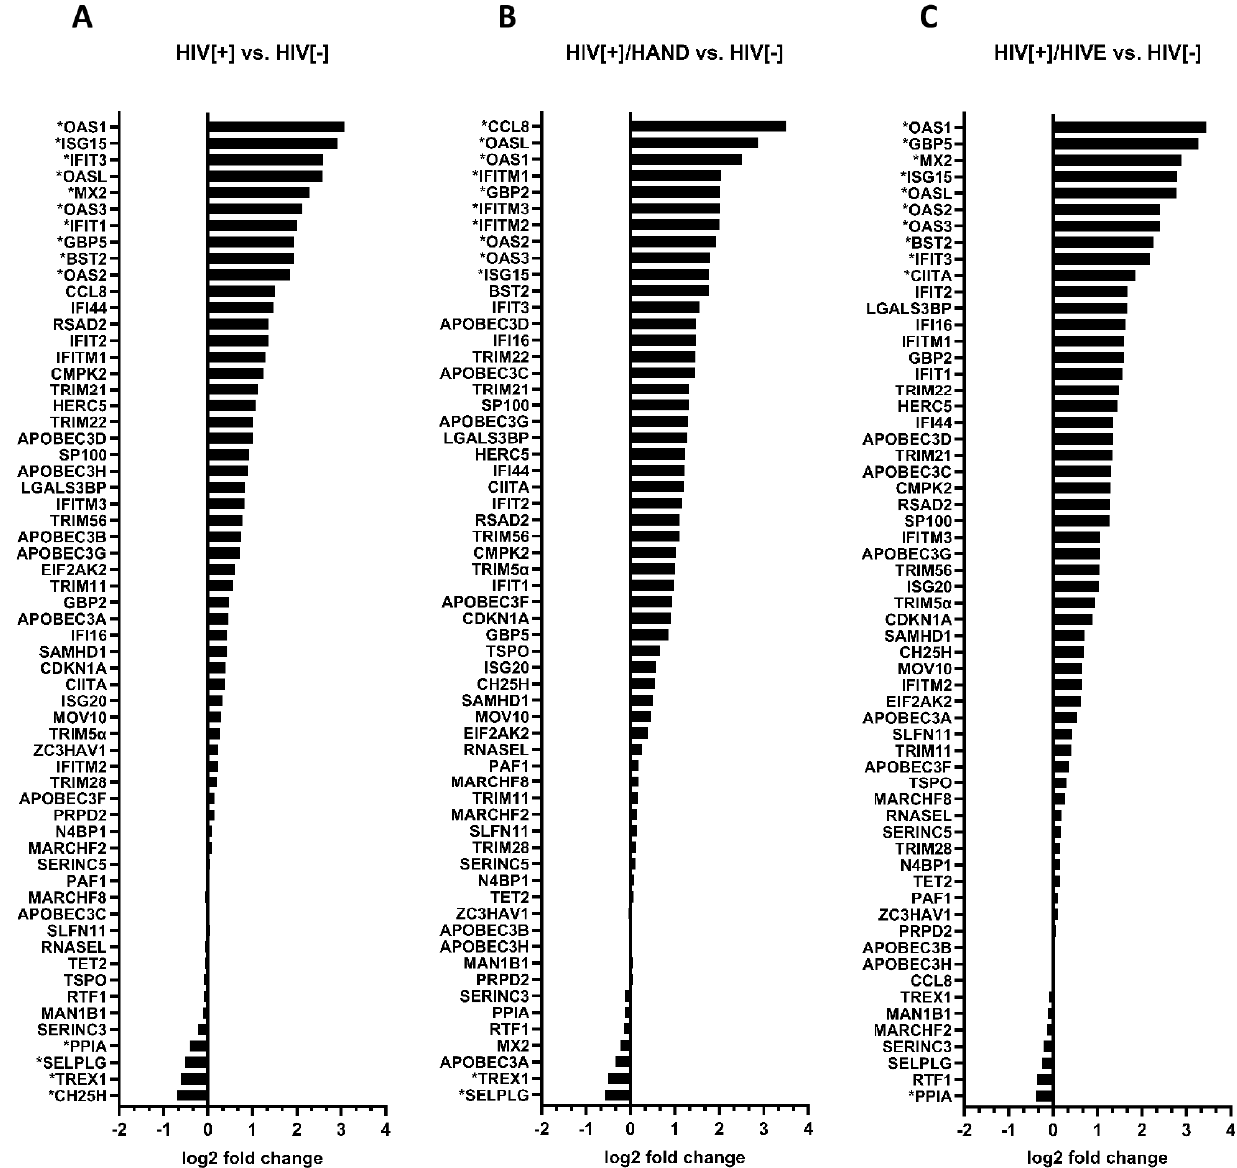
Figure 2. Relative host restriction factors’ mRNA expression levels. RNA isolated from the post- mortem brains of the human cohort was subjected to bulk RNA-seq. Sixty known restriction factor genes with HIV restrictive capabilities were screened in the RNA-seq dataset. Differentially expressed genes are reported in different group comparisons. ( A ) HIV[+] compared to HIV[ − ], ( B ) HIV[+]/HAND compared to HIV[ − ] and ( C ) HIV[+]/HIVE compared to HIV[ − ]. The fold changes range from − 2 to − 1, 0, 1, 2, 3 and 4 log2 fold changes (or 0.25, 0.5, 1, 2, 4, 8 and 16-fold changes). Genes with 0 to − 2 log2 fold changes are considered downregulated, and those with 0 to 4 log2 fold changes are considered upregulated. Asterisks indicate the genes that were selected for validation by